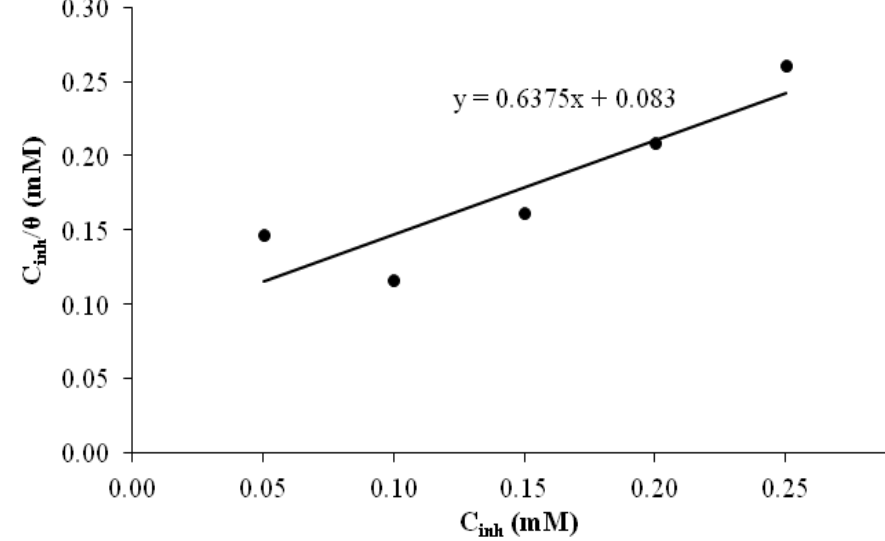
Figure 5. Adsorption isotherm for mild steel in 1.0 M H of the corrosion